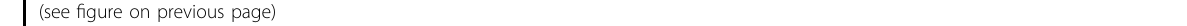
Fig. 4 Dynamic metabolomics pro fi ling. a Stream graph showing the differentially expressed metabolites, split into four categories (lipid, amino acid, nucleotide, and others), between the SC and LC groups (|Log 2 (fold change (FC))| > 0.25, Welch ’ s t -test P < 0.05). A positive number of metabolites represents their upregulation while a negative number represents their downregulation in the LC group. b The sub-classi fi cations of the differentially expressed metabolites in four subcategories (as in a ). The length of the circular sector represents the number of metabolites belonging to a sub-pathway. Sub-pathways containing> 1 metabolite are annotated. c The histogram showing that the top three or two dysregulated metabolites between the LC and SC groups in each week. Orange: upregulated metabolites in the LC group; blue: downregulated metabolites in the LC group; |Log 2 (FC)| > 0.25, Welch ’ s t -test P < 0.05). d Connection between the differentially expressed metabolites, the time-point, and the enriched KEGG pathways. Left: bubble plot showing the differentially expressed metabolites between the LC and SC groups (FC > 1 represents upregulation, whereas FC < 1 represents downregulation, in the LC group); the size of the bubbles represents the degree of signi fi cance of the difference between the LC and SC groups. Middle: the sizes of the circles represent the numbers of the differentially expressed metabolites at each week. Right: KEGG pathways annotated with the deeper background-colored circle. Blue or red rectangles represent downregulated or upregulated metabolites in the LC group, respectively. The interaction plot was generated using